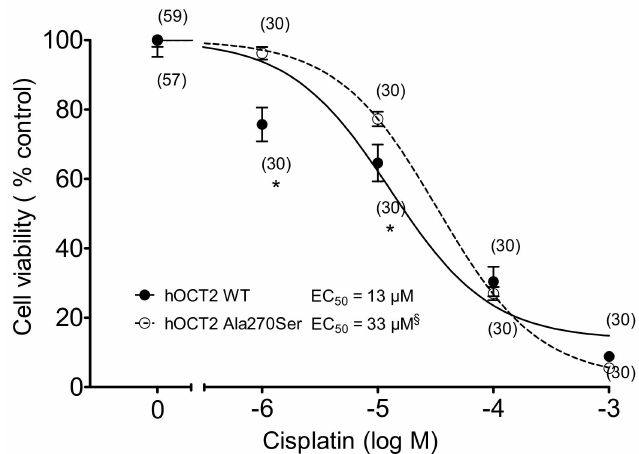
Figure 5. Cell toxicity induced by 10 min incubation with increasing cisplatin concentrations measured withanMTTassay(mean ± SEM)inhOCT2WT( (cid:8) , continuedline)andhOCT2Ala270Ser(